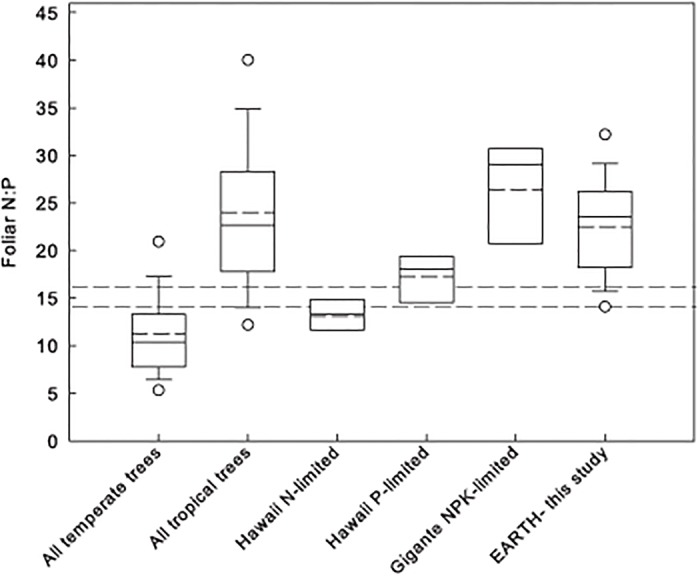
Box plots showing foliar N:P ratios at EARTH Forest relative to other forests.The dashed line is the mean, the 25th and 75th percentiles are encased in the box, the whiskers are the 10th and 90th percentiles and the dots are the 5th and 95th percentiles. Data for all temperate and tropical trees are from [17,20]. Hawaii data are from [16]. For the last four sites, each data point was a species mean across control plots. Dashed lines indicate the 14–16 N versus P limitation threshold.